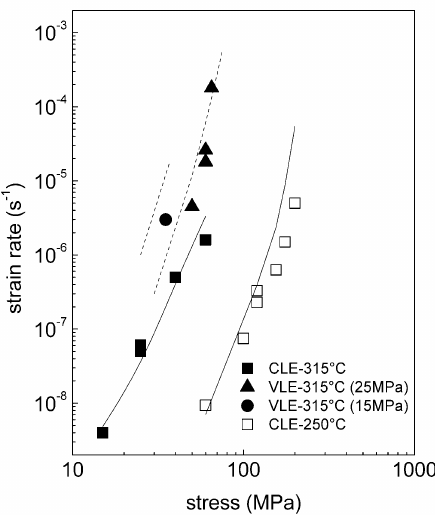
Figure 7. Minimum creep rate dependence on applied stress. The solid curves connect the modelled values of the strain rate for each single CSE; the broken curves connect the strain rate values modelled by assuming that the time of exposure does not change appreciably for the tests carried out under different loads. The latter condition is comparable to the conditions experienced during the VLE. The grain size used in estimating the internal stress was 50 µm.